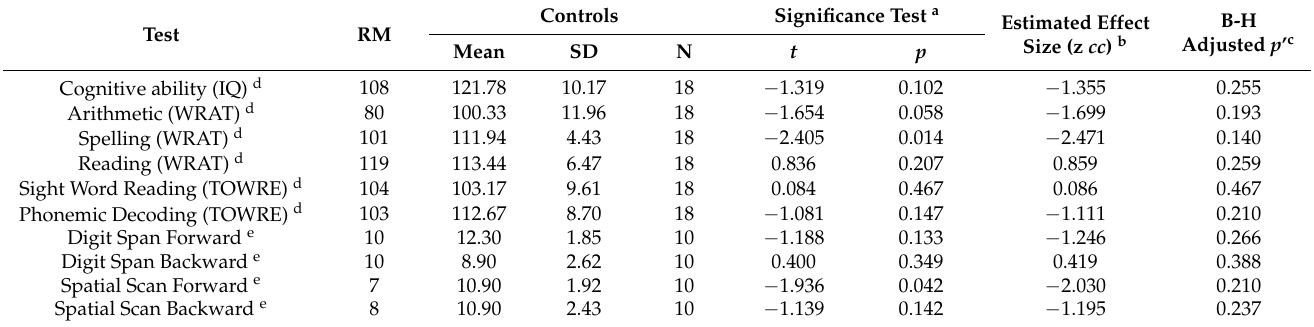
Table 1. Background variables for a single case with developmental dyscalculia (RM) and